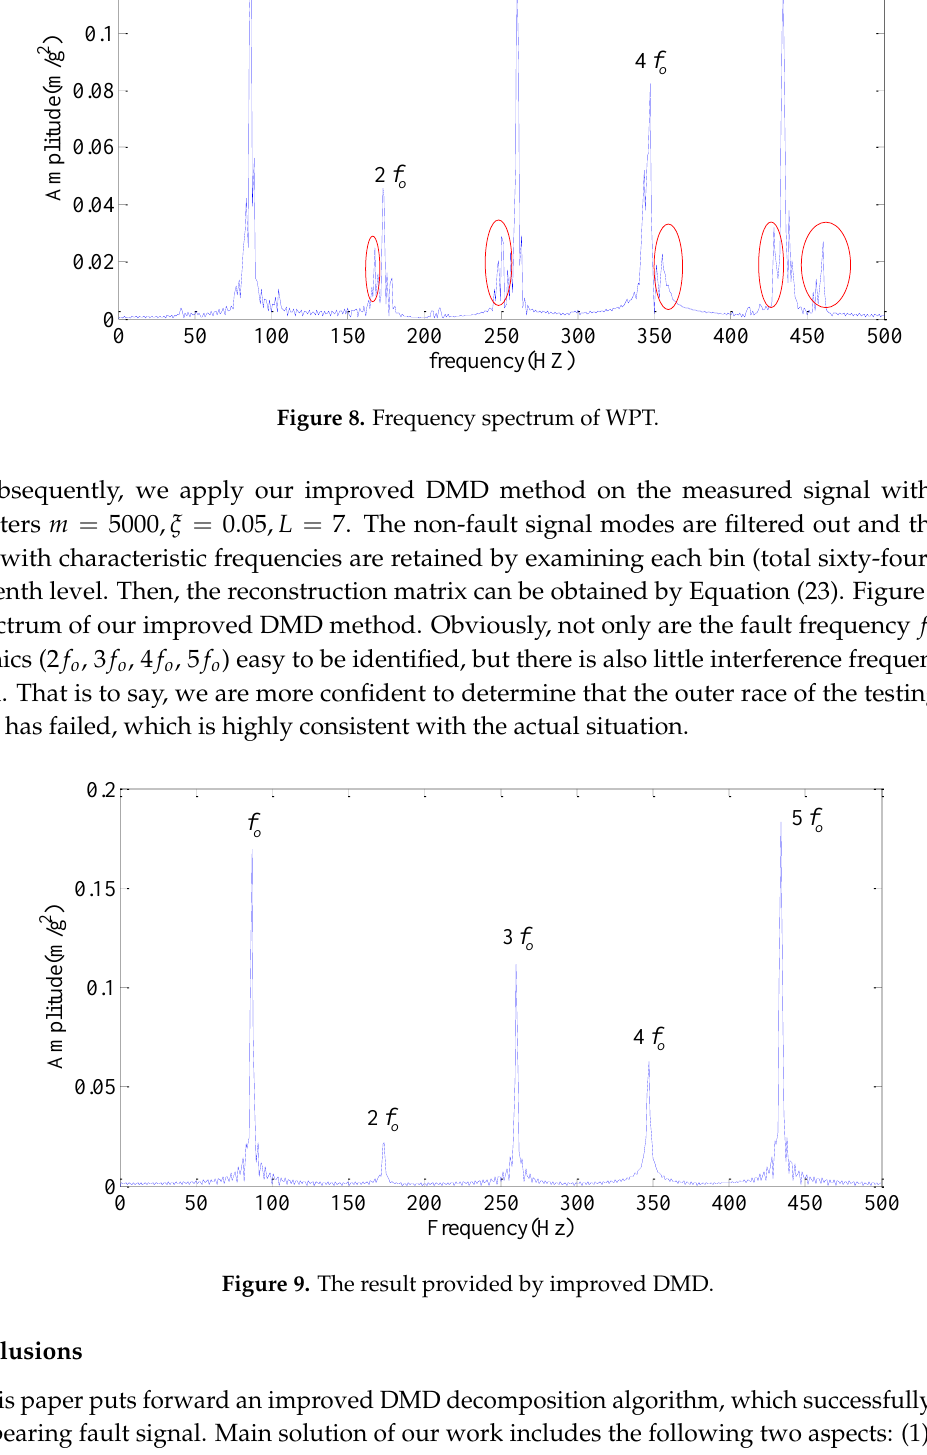
Figure 7. The measured signal in the time domain and frequency spectrum: ( a ) time domain; ( b ) FFT spectrum; ( c ) envelope spectrum.